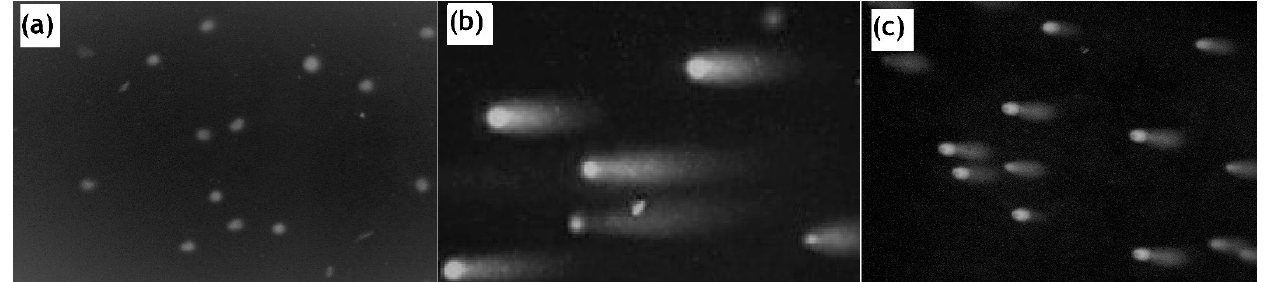
Figure 8. Comet assay applied for three different treatments: ( a ) control fibroblasts (no treatment); ( b ) fibroblasts treated with H 2 O 2 for 10 min; ( c ) fibroblasts exposure to H 2 O 2 for 10 min, and then treated with AALipo20% for 60 min.